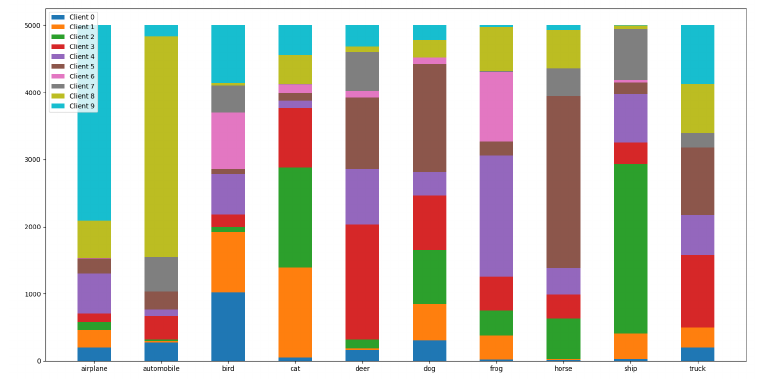
Figure 6. Dirichlet distribution.